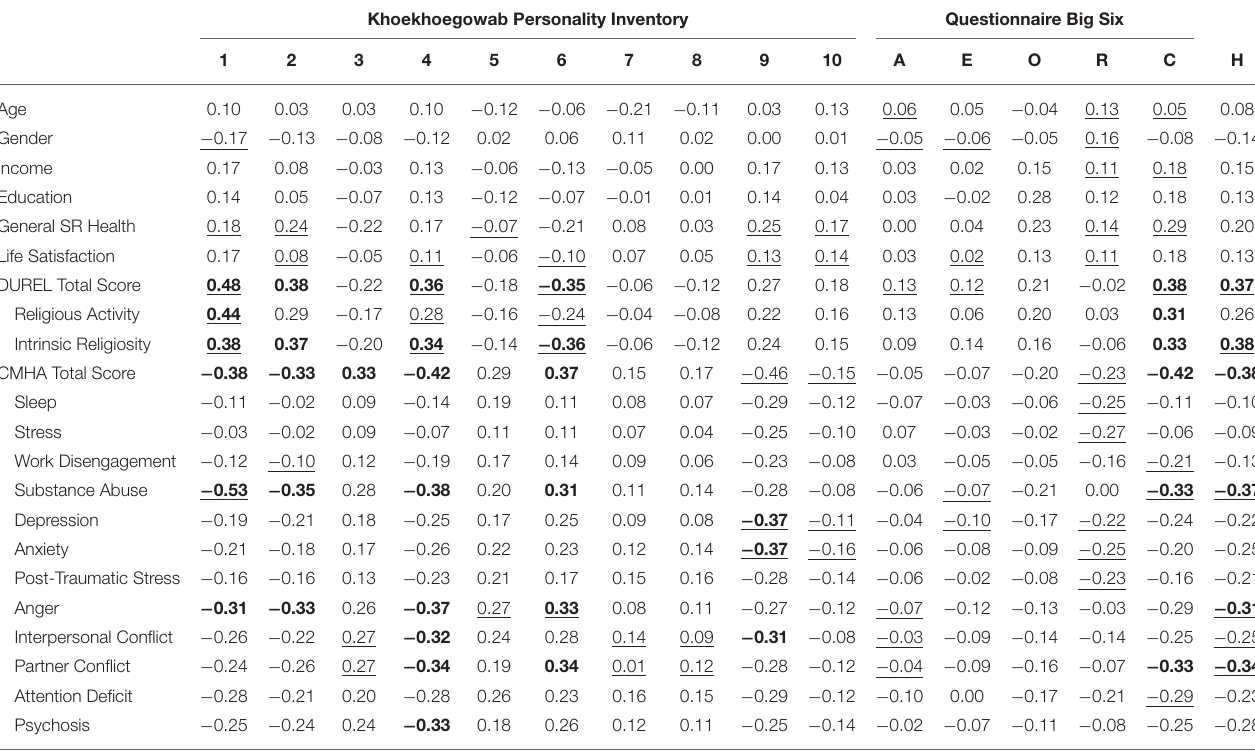
TABLE 4 | Correlations Between Personality Scales and Demographic and Criterion Variables. Khoekhoegowab Personality Inventory Questionnaire Big